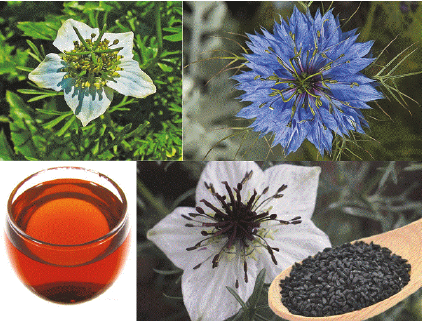
Figure 1: Nigella sativa plant, seed, and oil.